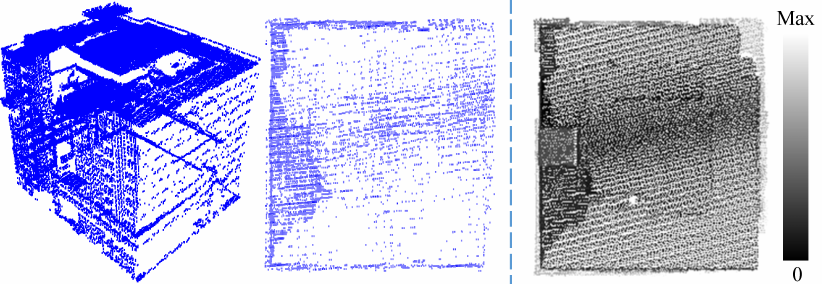
Figure 2. Depth image. ( Left , Middle ): perspective and top views of point cloud, respectively; ( Right ): top view of depth image.